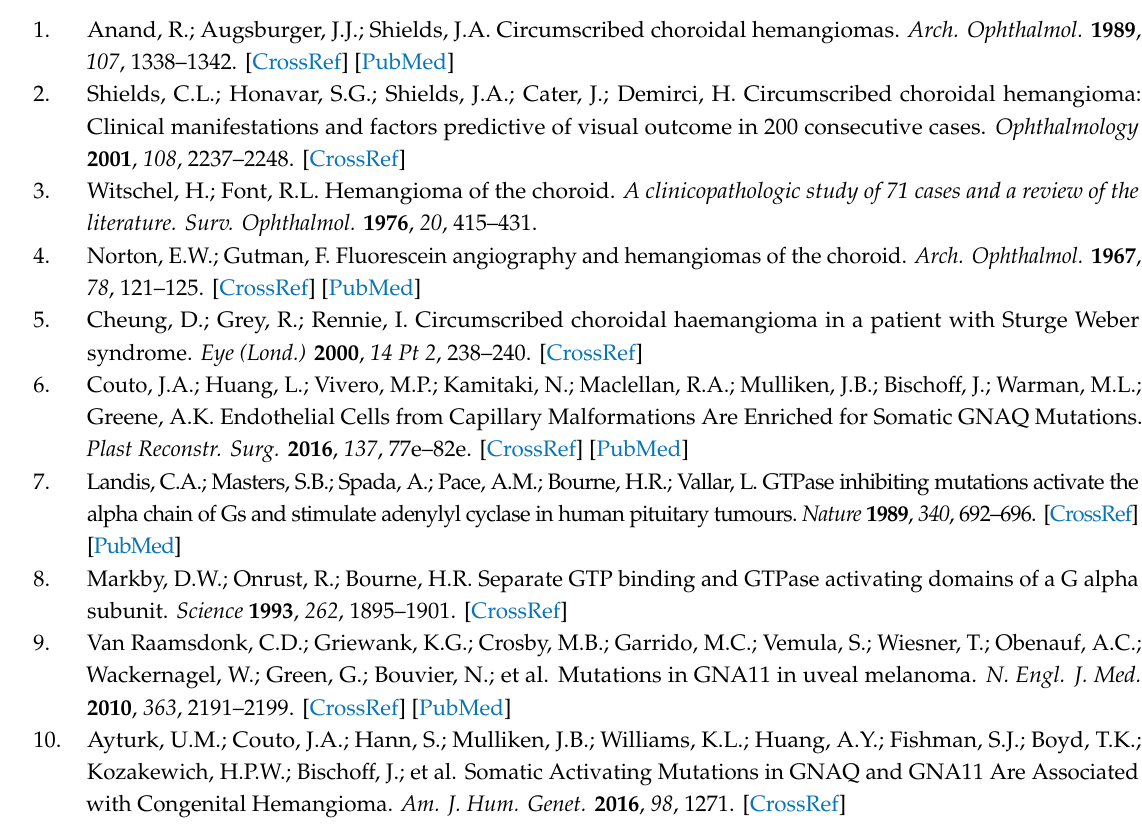
Figure S1: Visual acuity at initial and last presentation, Figure S2: Dot plot showing relationship of age at diagnosis vs. duration of symptoms in mutation positive CCH patients, Figure S3: Distribution of the variant allele fractions over the CCH samples (n = 33), Figure S4: Standard curve, Table S1: Oligonucleotides for deep amplicon sequencing on Illumina MiSeq, Table S2: Number of samples with GNAQ / GNA11 mutations in di ff erent tumor